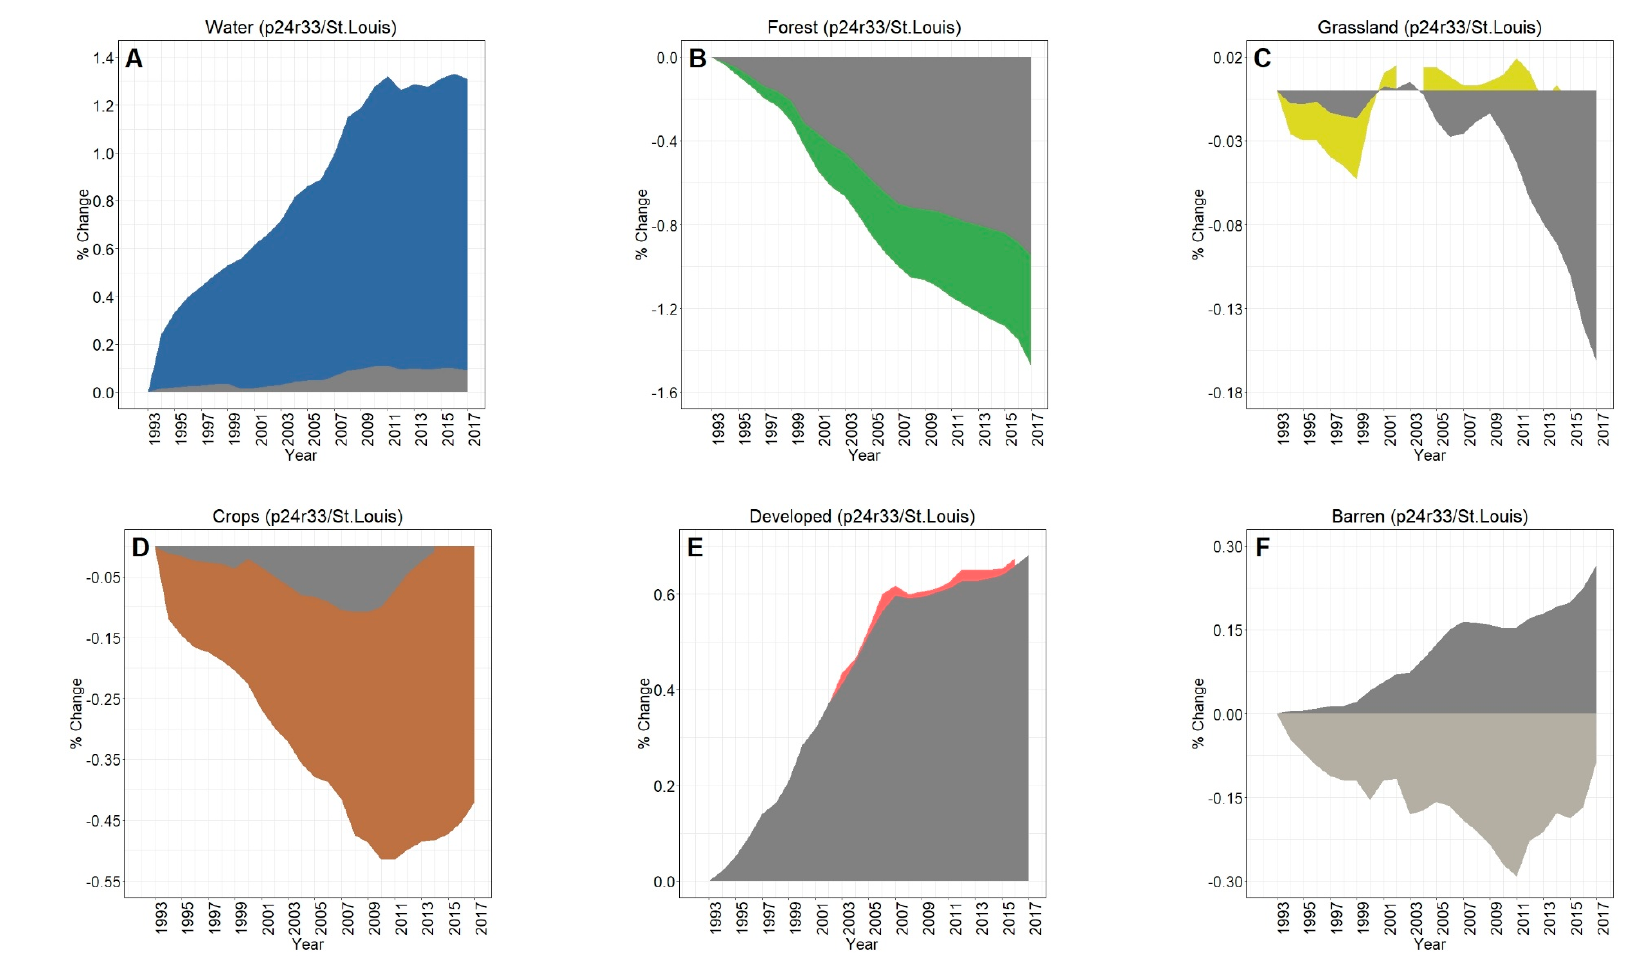
Figure 11. Contrasting LULC change in the areas buffering waters with the St. Louis-area footprint-wide change for ( A ) water, ( B ) forest, ( C ) grassland, ( D ) crops, ( E ) developed, and ( F ) barren classes.